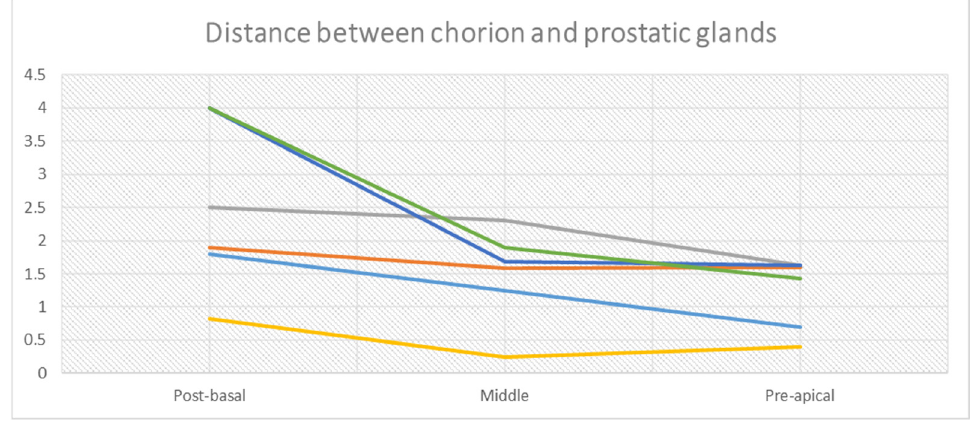
Figure 7. Mean distance between prostatic urothelium and prostatic glands of all six specimens (progressively from basal to apical portions).